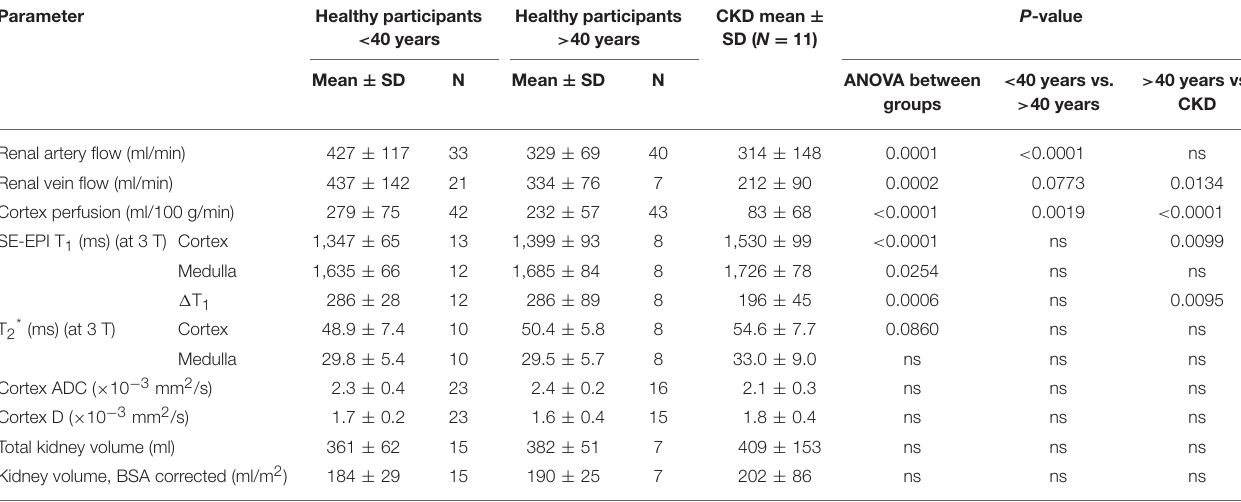
TABLE 5 | Multiparametric MRI measures in healthy participants split according to age and Chronic Kidney Disease patients. Parameter Healthy participants